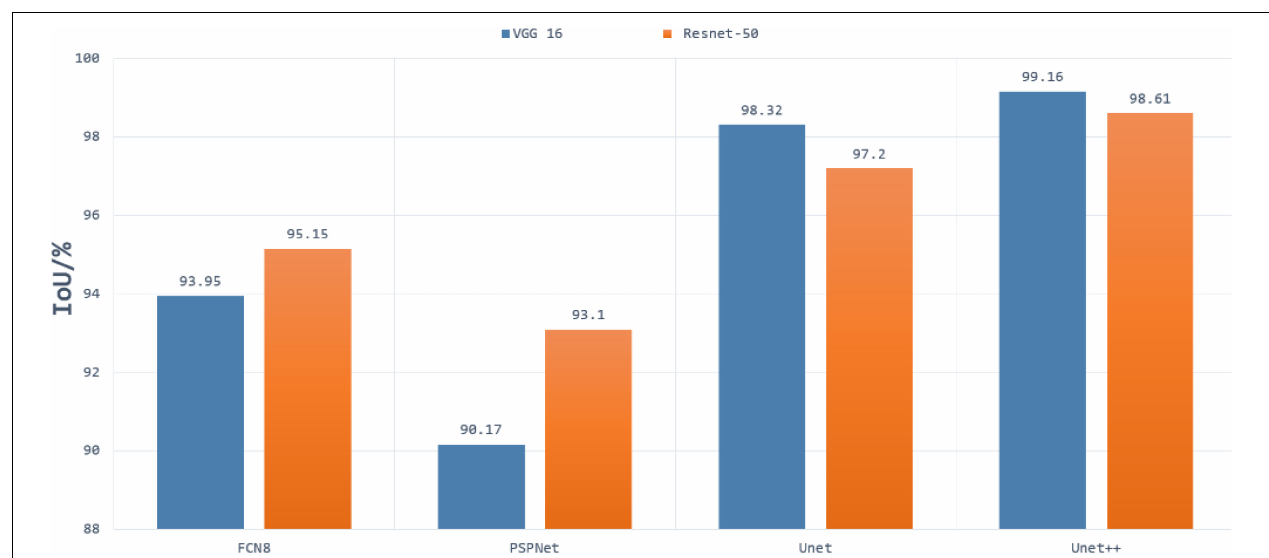
FIGURE 3 | Results of segmentation using Resnet50 and VGG16 as backbone in FCN, PSPnet, U-Net, and U-Net++ architectures.